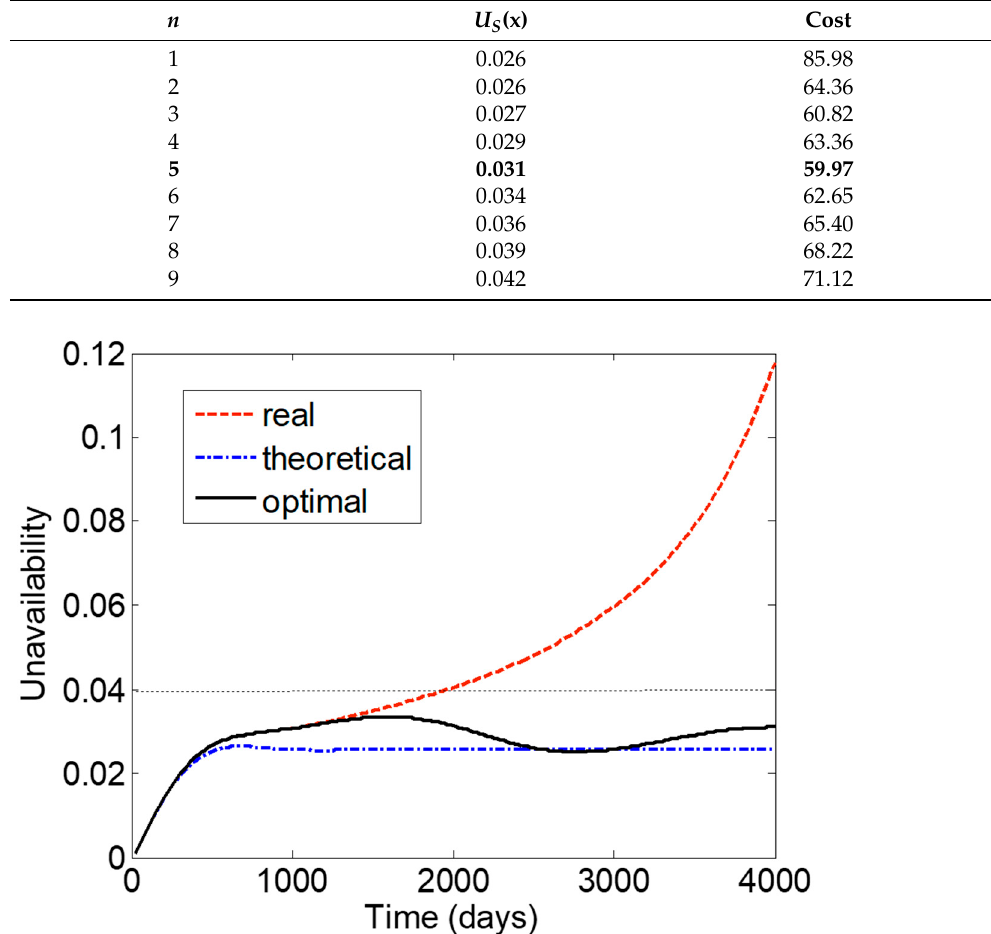
Figure 5. Comparison of courses of the unavailability function u ( t ) for three different system modes. The optimal value for the decision variable n = 5 respecting the given unavailability restriction U 0 = 0.04. Table 1. Results for the optimization process for decision variable n in a one-component system.